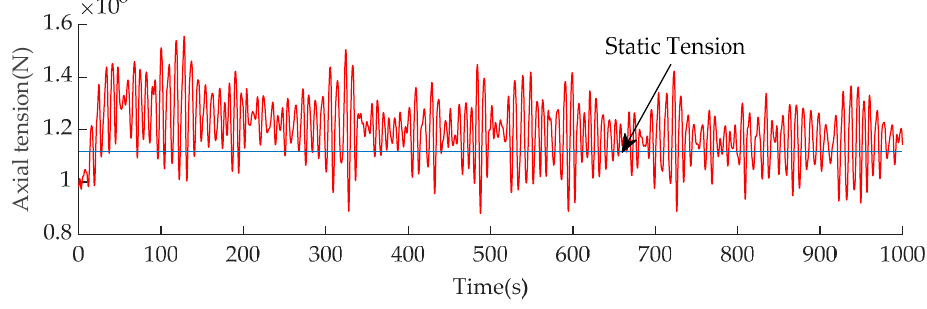
Figure 15. Time histories for the pipeline top tension force.